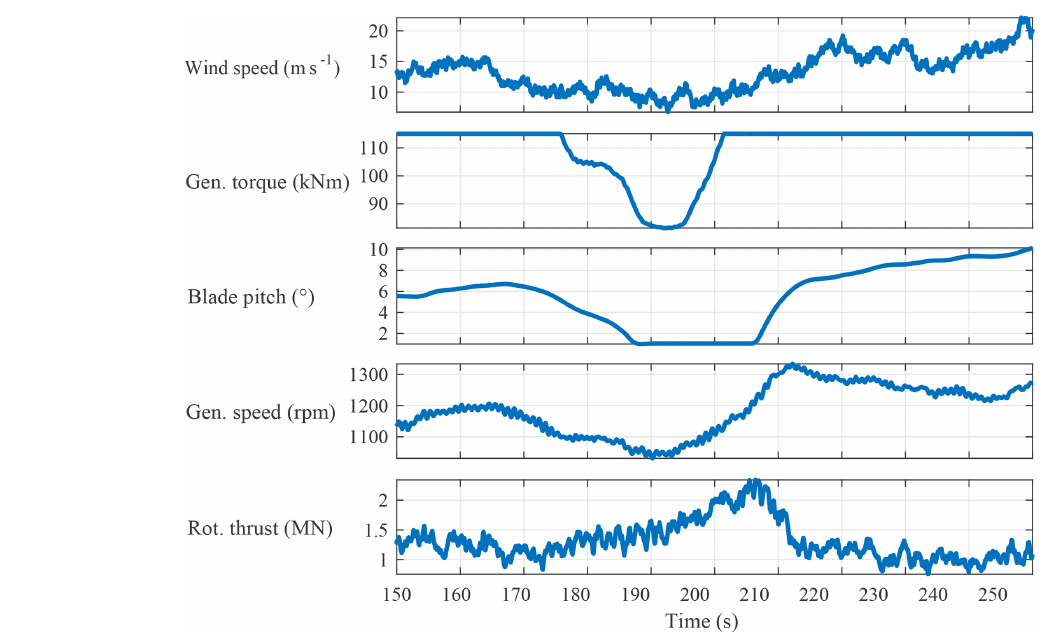
Figure 3. Baseline control illustration of a problematic gust for the SUMR-13A baseline rotor in extreme turbulence (DLC 1.3) with a mean wind speed of 14ms − 1 . The peak rotor thrust near 205s causes the peak blade flapwise load for the